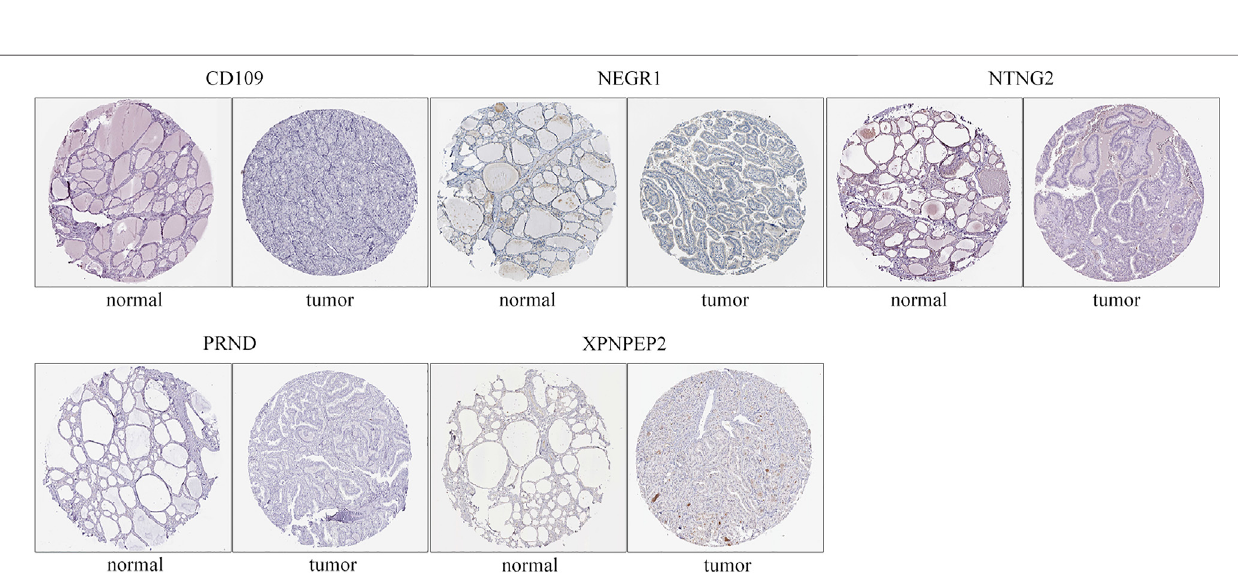
FIGURE 9 | Protein expression of critical genes. Images were obtained from the HPA